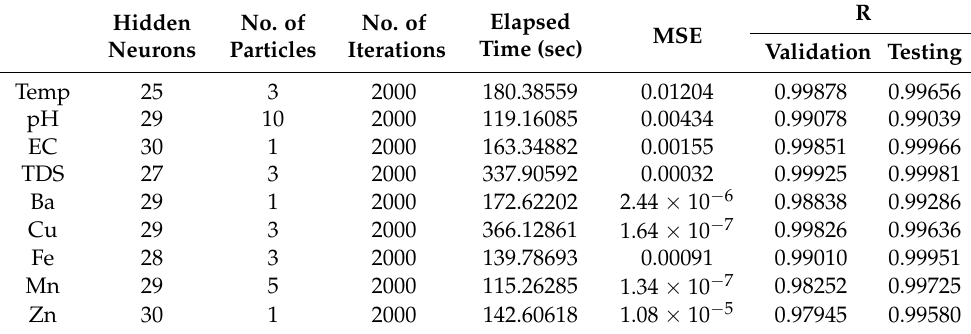
Table 5. NN-PSO Simulation